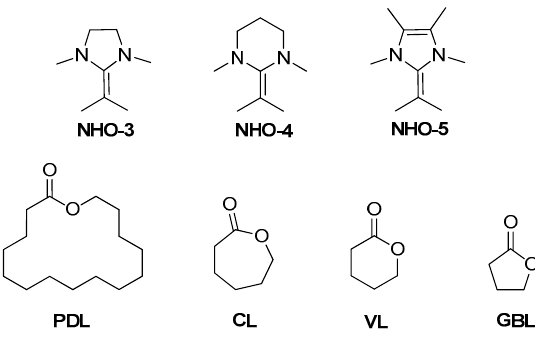
Scheme 12. Schematic representation of the proposed polymerization mechanism, including possible adduct formation.